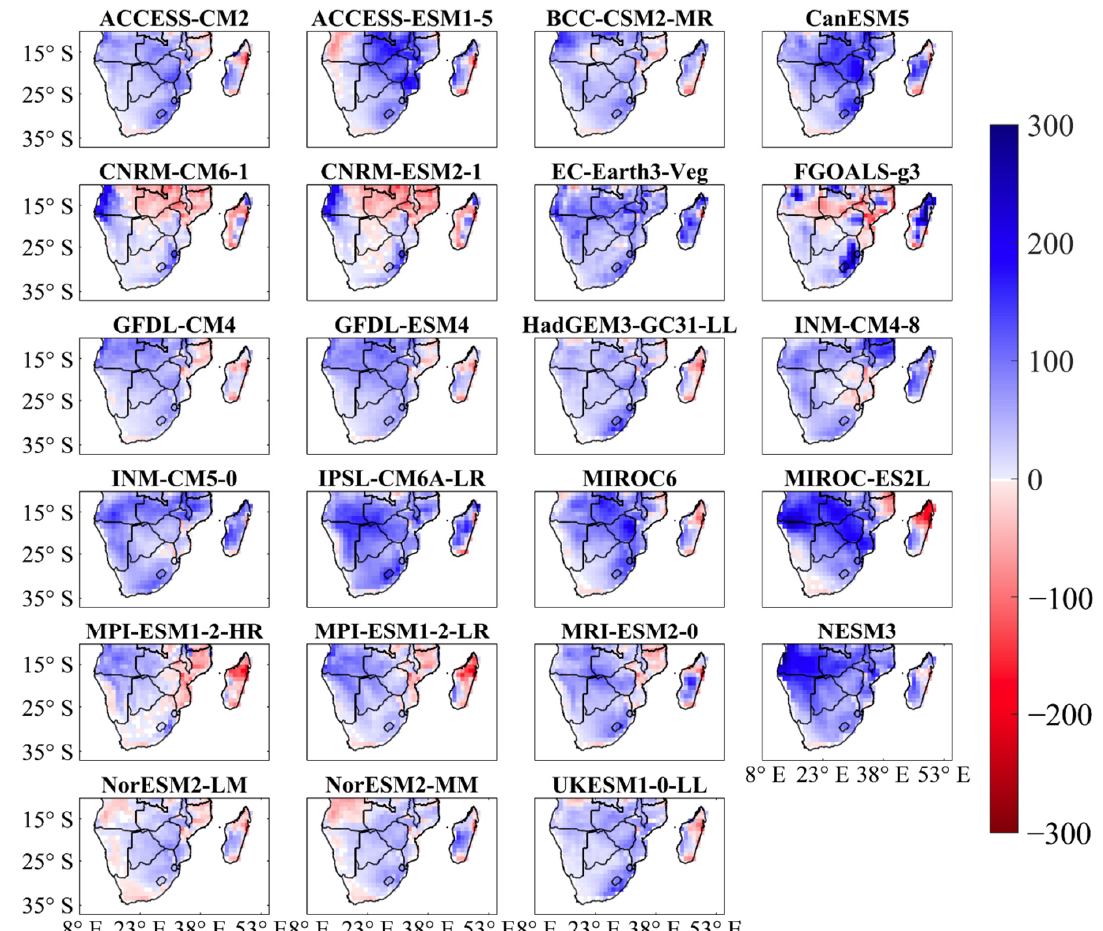
Figure A2. Spatial distribution of DJFM seasonal precipitation anomaly (mm) averaged from 1901 to 2014 over Southern